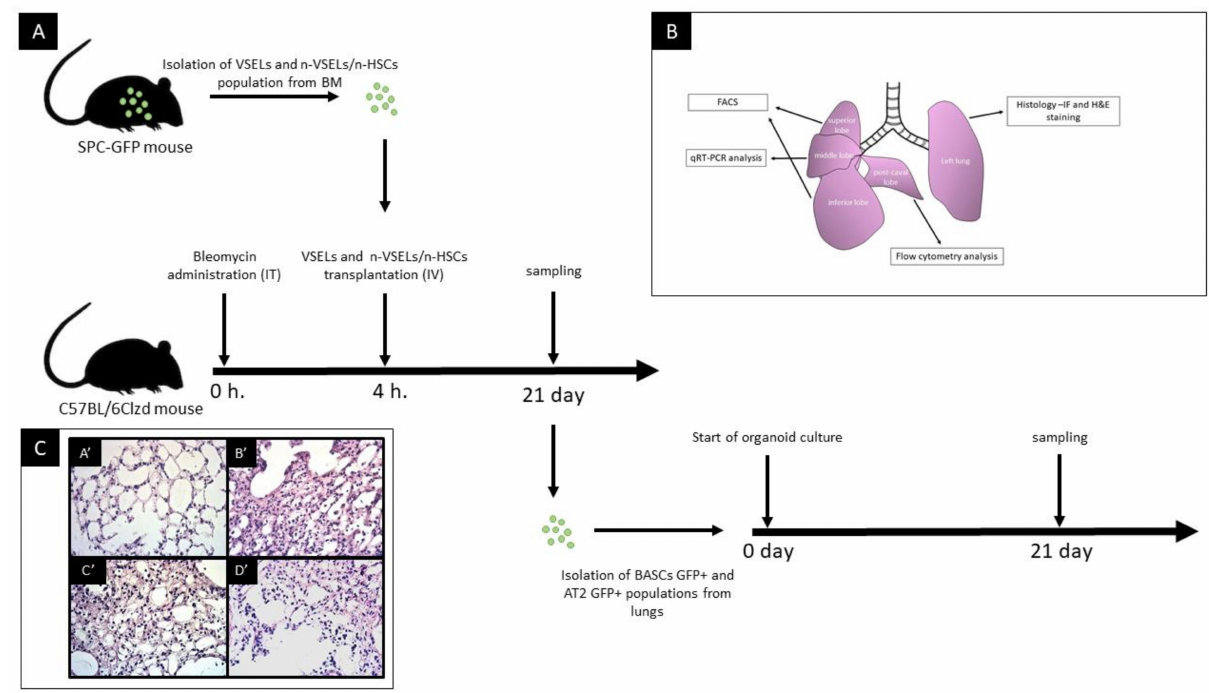
Figure 1. Panel A : schematic of study design. IT—intratracheal route of administration; IV—intravenous route of ad- ministration. Panel B : schematic of tissue harvested for different analyses as indicated. Panel C : representative images of lung tissue sections from 21 days after bleomycin administration, paraffin embedded and H&E stained. Images were taken at 100 × magnification. Histological picture of lung biopsies varies over time from the acute phase followed by fibrotic changes—mainly bronchiolar and peribronchiolar. In our histopathological study assessment performed at d21, time of chronic phase injury characterized by thickening of alveolar septa, varying degrees of thickening of airway wall and peribronchiolar spaces in association with inflammatory cell infiltration. A’ : NB group (untreated control). Normal histological appearance of lung.; B’ : Bleo only mouse; C’ : Bleo + VSEL mouse; D’ : Bleo + non-VSEL/non-HSC